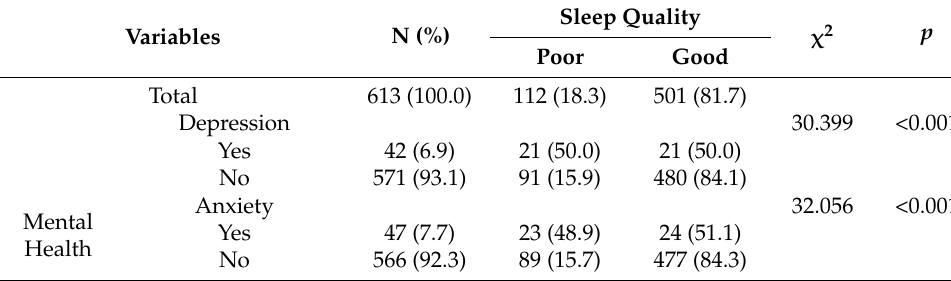
Table 2. Chronic disease, mental health, and sleep quality of